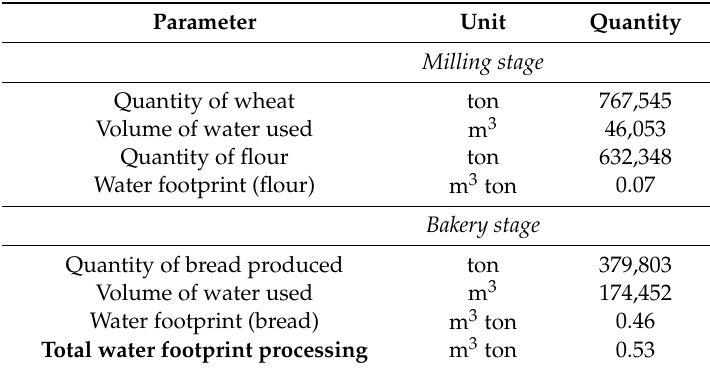
Table 5. Water use at the processing stage of the value chain (milling and bakery).